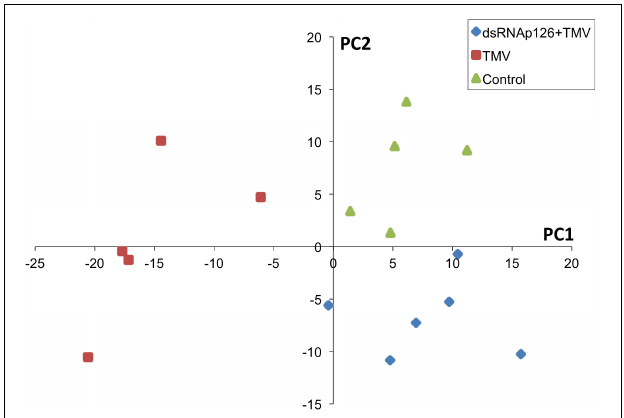
FIGURE 1 | Partial least squares discriminant analysis (PLS-DA). Components 1 and 2 of the PLS-DA show a significant correlation to the treatments and explain, respectively, 24 and 8% of the variability. Component 2 separates the dsRNAp126 + TMV and control treatments from the TMV treatment. Each sample point is a biological replicate. All samples were collected 15 min post